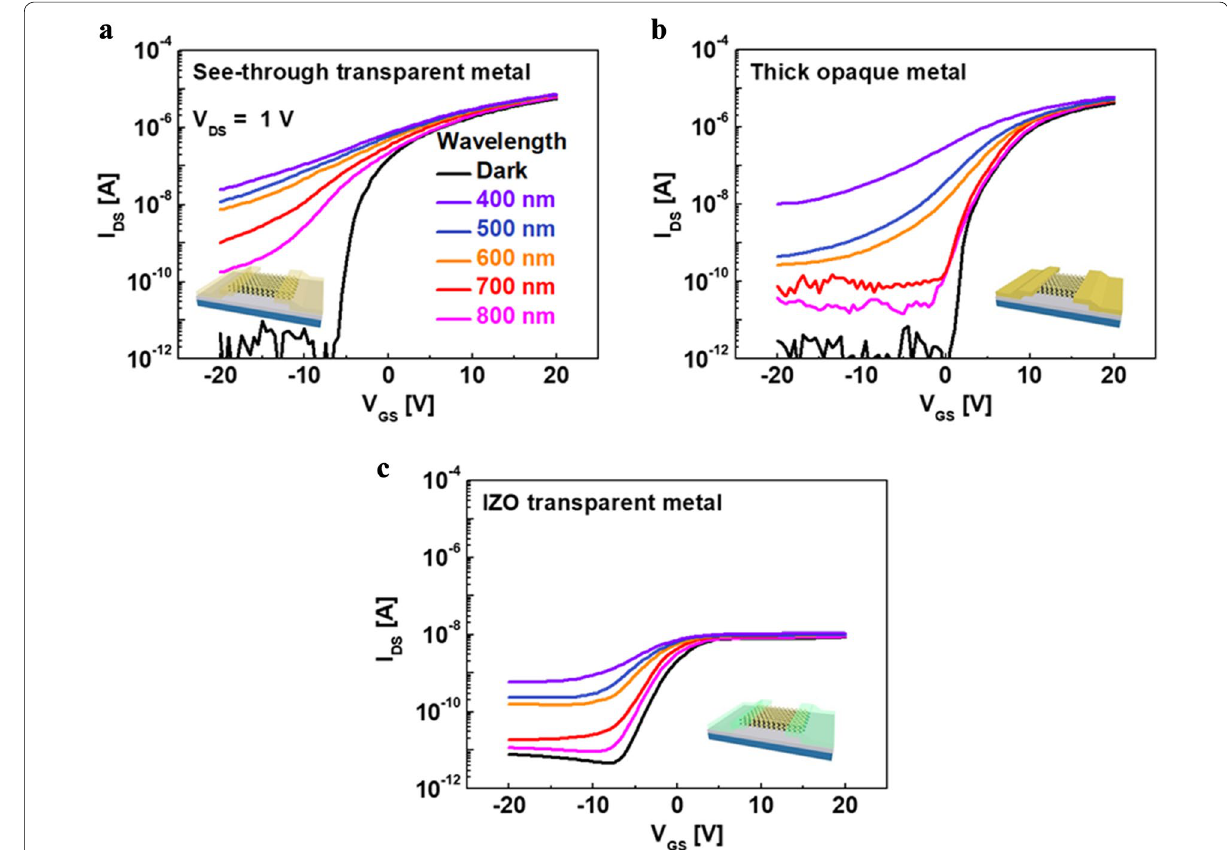
Fig. 3 I DS –V GS characteristics of the multi-layer MoS 2 phototransistor with a see-through metal, b thick opaque metal and c IZO transparent metal in the dark and under illumination at different wavelengths